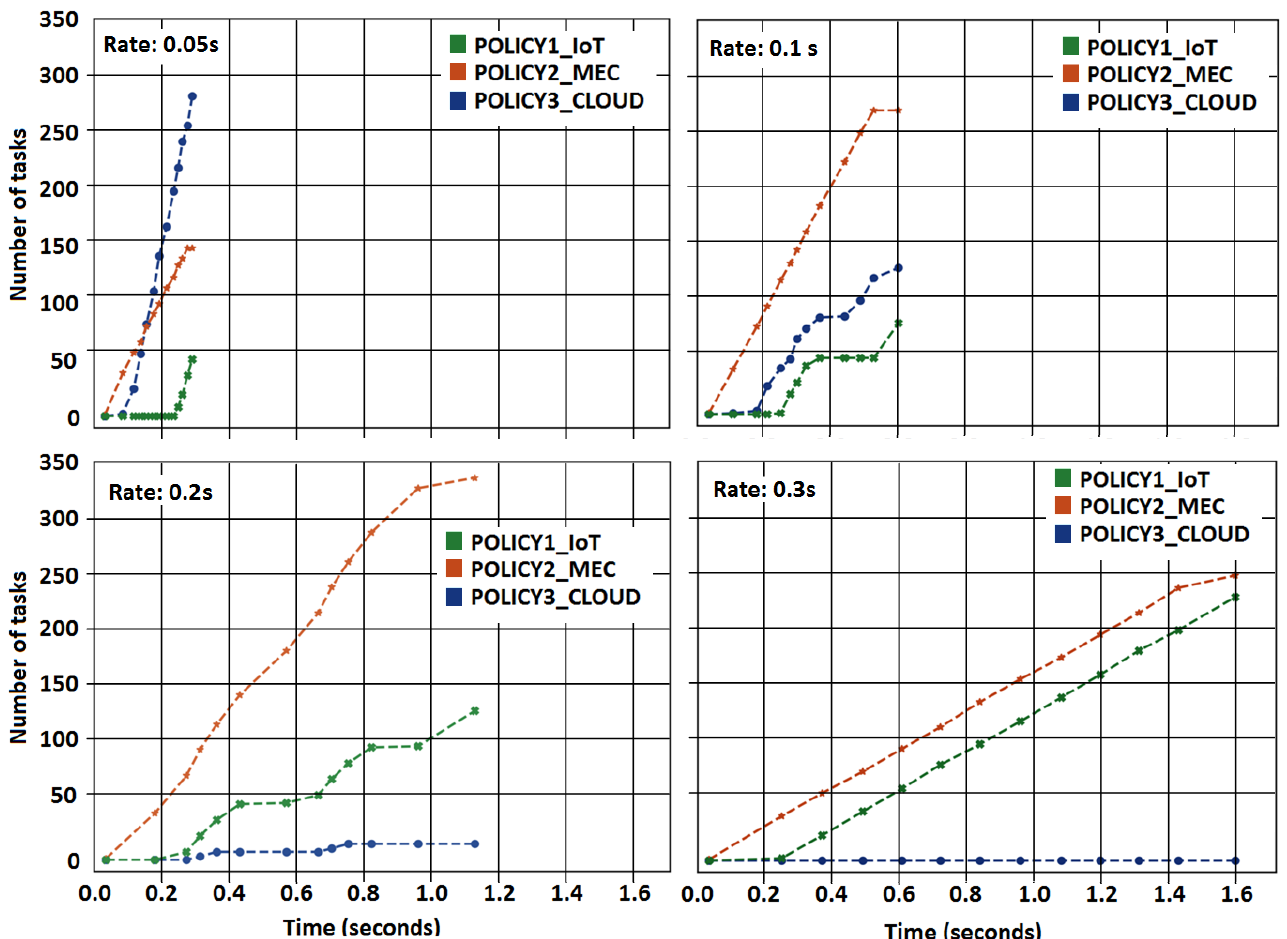
Figure 6. Task allocation for different task generation